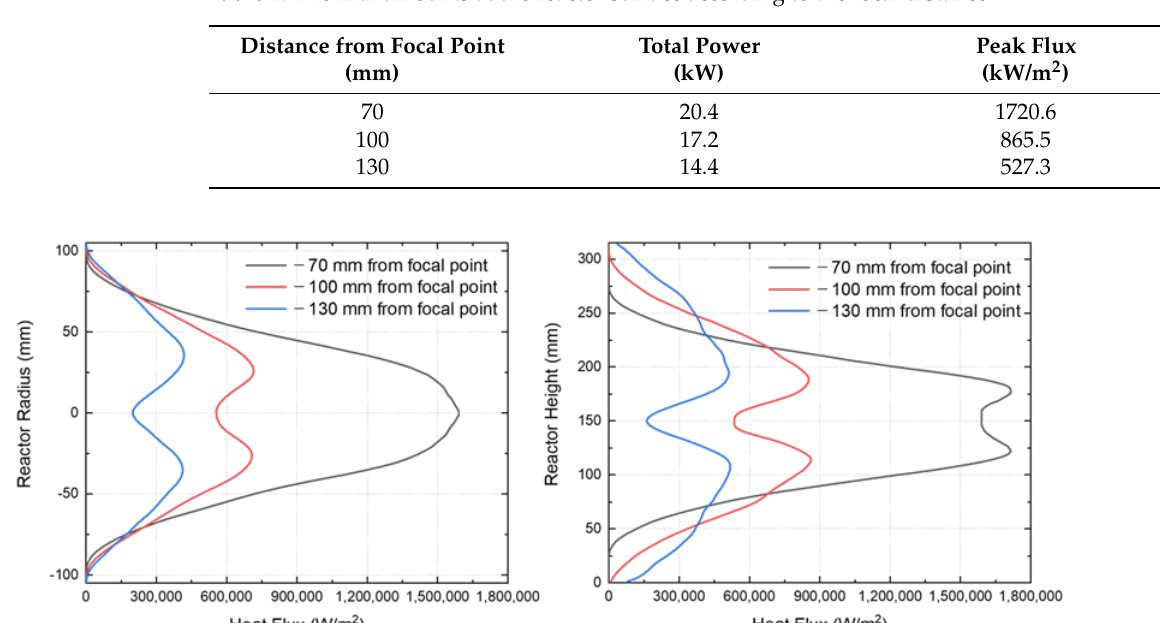
Figure 11. Heat flux distributions at the reactor surface depending on the focal distance according to reactor radius ( left ) and reactor height ( right ). Table 2. Thermal amounts at the reactor surface according to the focal distance.